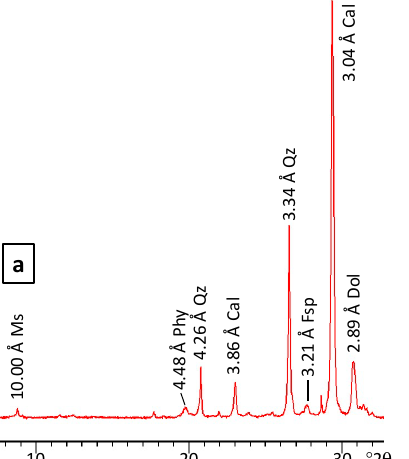
Table 5. XRD analysis of the samples along the scanline 1 in Altichuelas site in the southern segment of the Baza Fault. The distance corresponds to the distance from fault, which is also plotted on the x- axes of the plots in Figure 10.